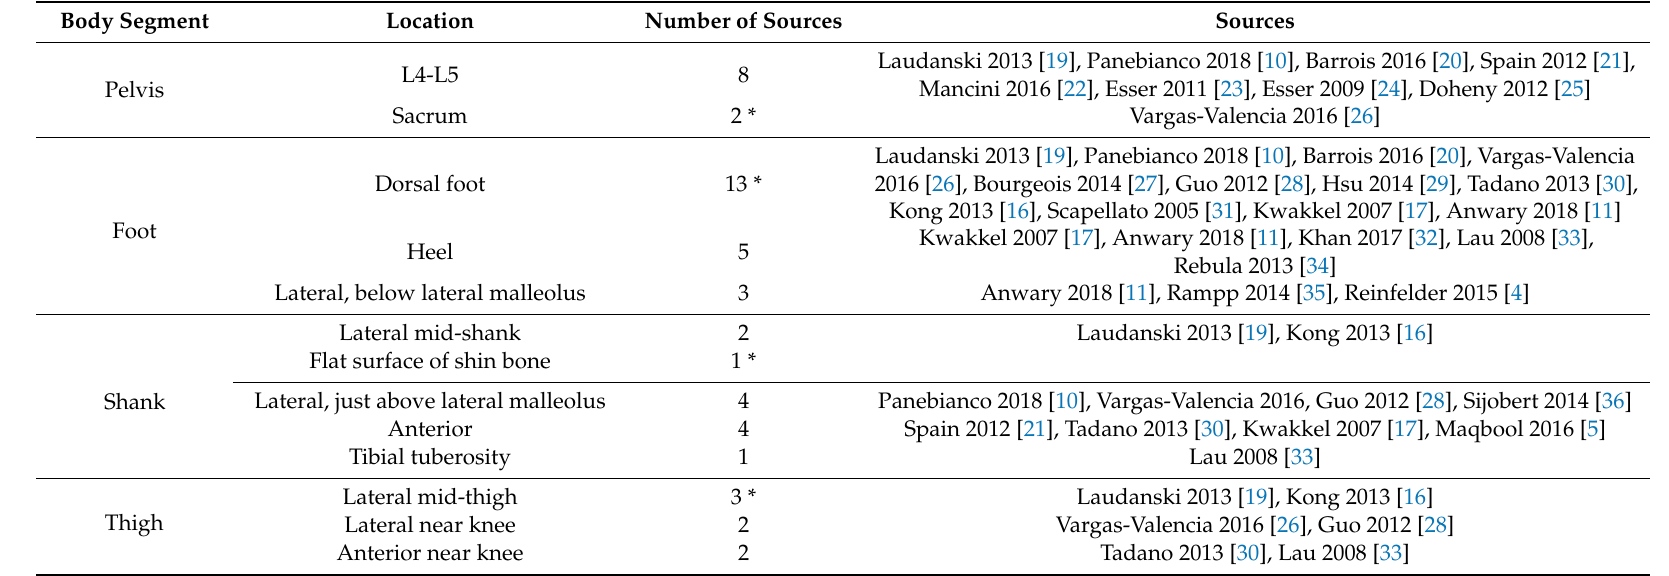
Table 1. Description of IMU sensors placements found in the literature and their sources. Recommendations from Xsens tutorials (https: // tutorial.xsens.com / ) are also included and denoted with a * in the source